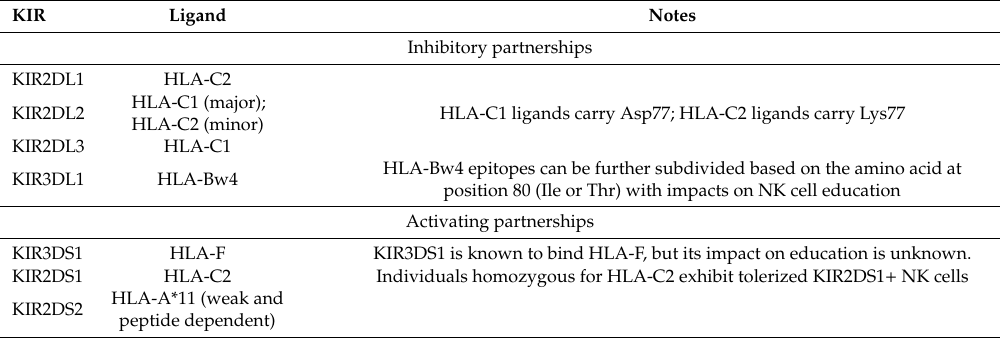
Table 1. Educating KIR-HLA